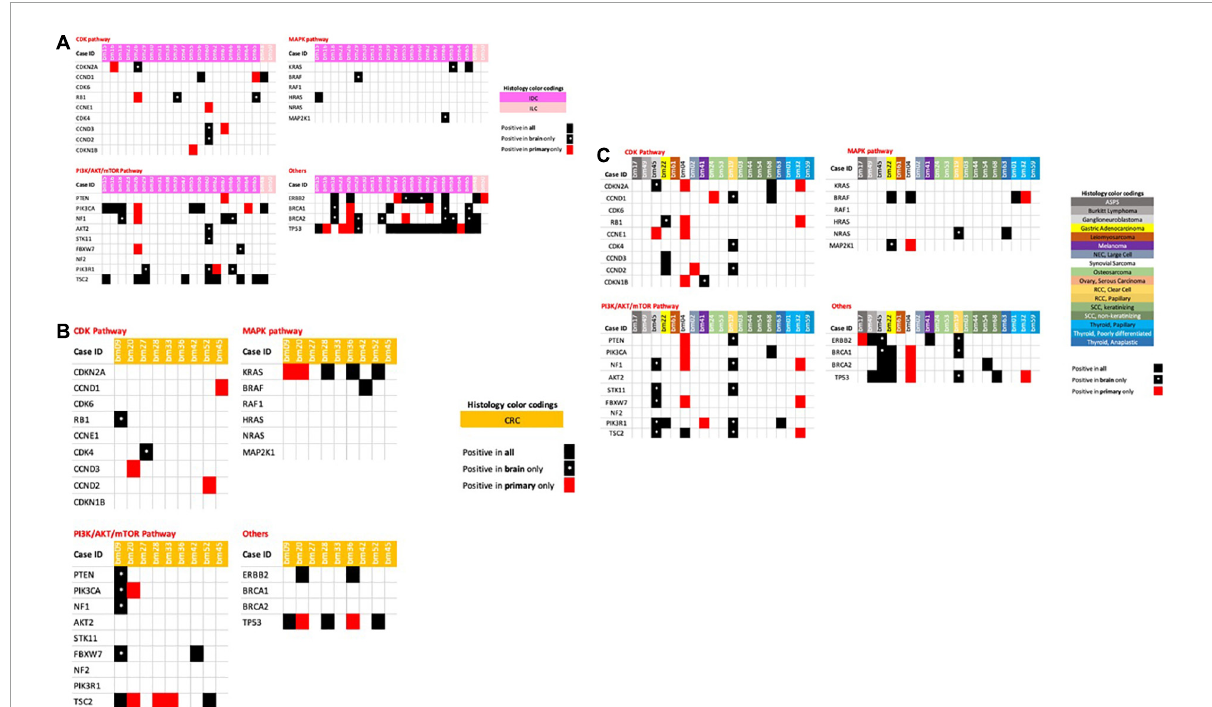
FIGURE2 (A) Breast cancer primary and metastatic tumors with associated genetic mutations. (B) Colorectal cancer primary and metastatic tumors with associated genetic mutations. (C) Miscellaneous/other tumors primaries and metastatic tumors with associated genetic mutations.